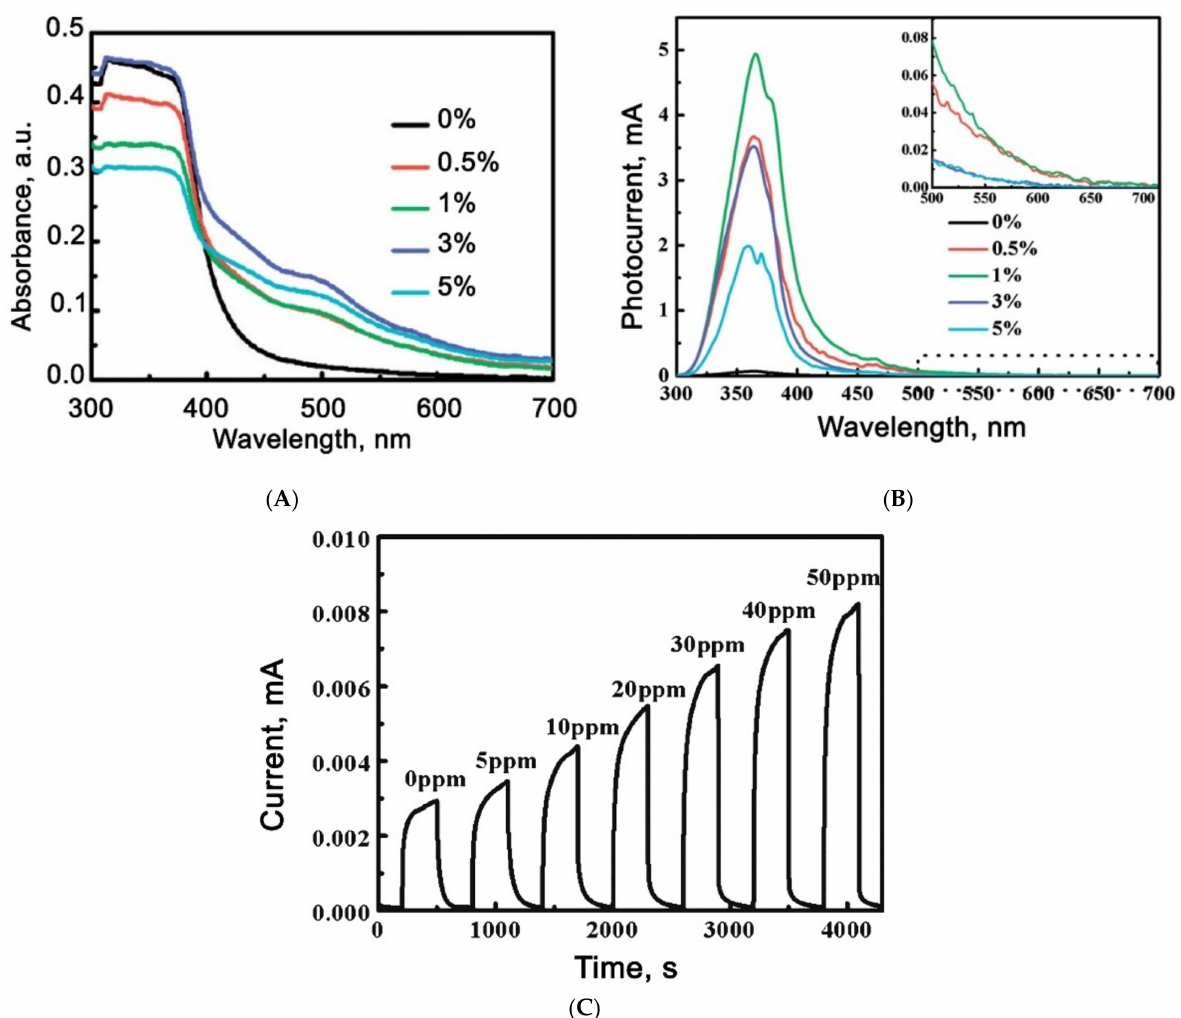
Figure 5. ( A ) Absorbance spectra of pure and Fe-doped ZnO; ( B ) photocurrent spectra of pure and Fe-doped ZnO; gas sensing measurements of 1% Fe-doped ZnO to formaldehyde under green laser illumination; ( C ) Gas sensor measurements to HCHO under 532 nm light illumination. Reprinted from [121] with permission from the American Chemical Society,